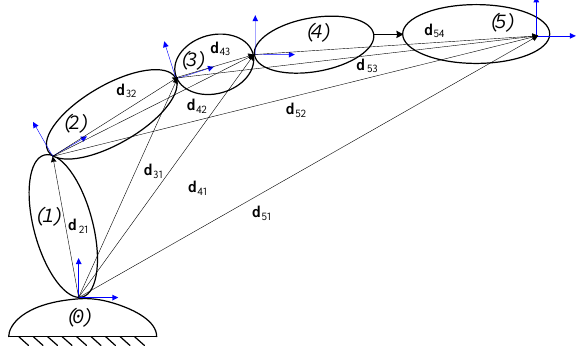
Figure 5: Distance vectors.